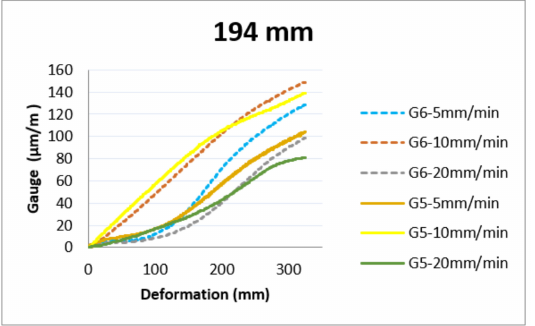
Figure 19. Deformation of Gauges 5 and 6 at each position for a diameter of 194